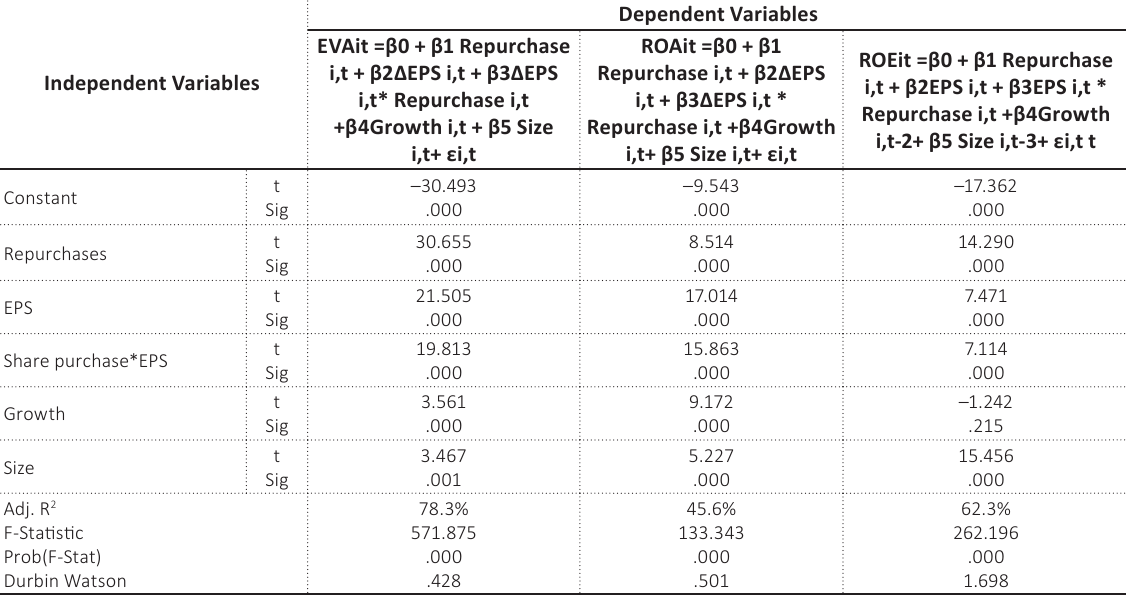
Table 7. The interactive effect of the average change in earnings per share and share buyback on financial